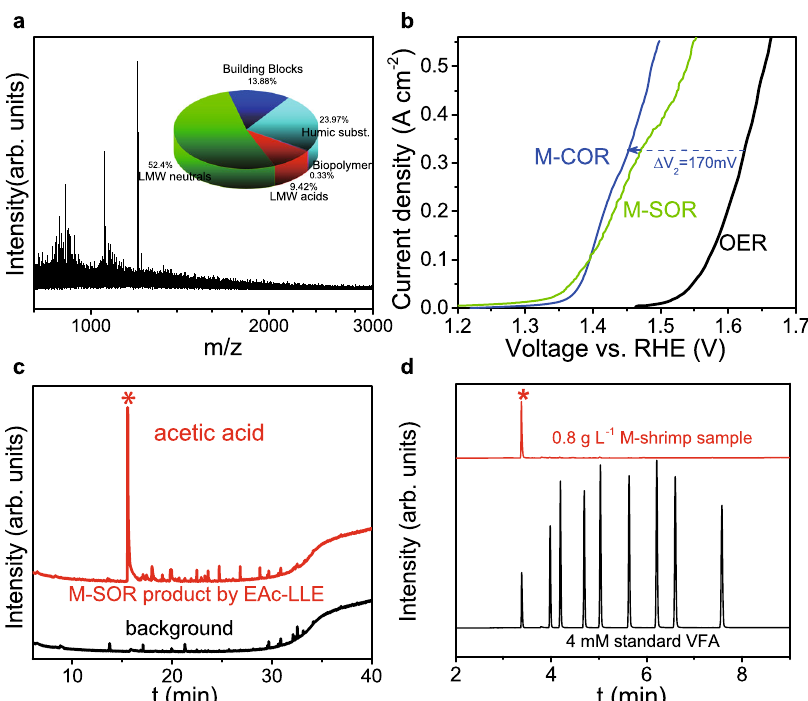
Fig. 5 Electrochemical conversion of M-shrimp shell. a MALDI-ToF mass spectra of soluble products from ball-milled crude shrimp shell. Inset: soluble substances fractionation of ball-milled shrimp shell. b LSV of anodic reactions at 5 mV s − 1 in 1.0 M KOH with 6.0 g L − 1 milled shrimp shell (green curve labeled with M-SOR). The anodic OER (black curve) and M-chitin oxidation reaction (blue curve labeled with M-COR) curves are also plotted